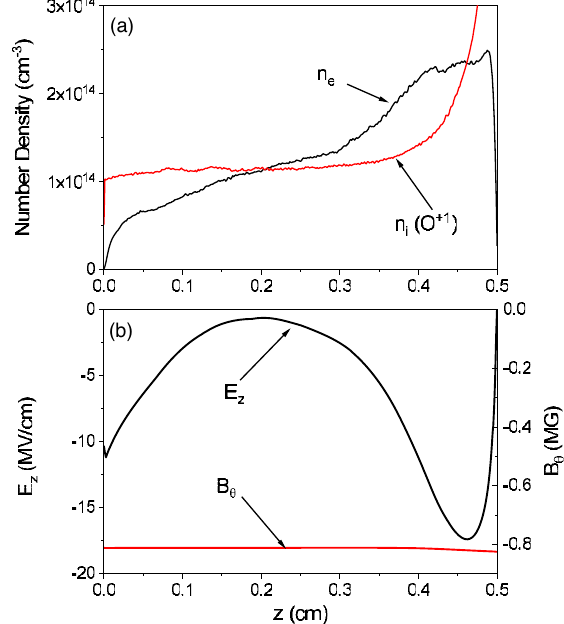
¼ 500 kA and e 0